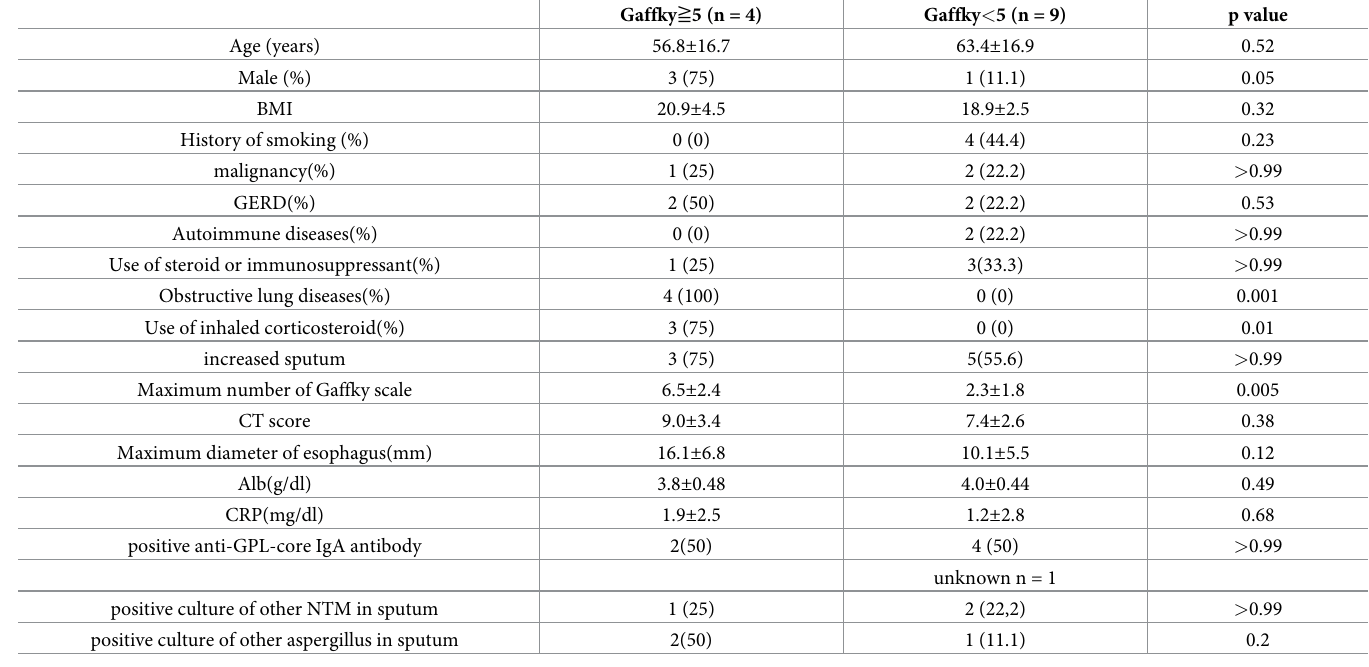
Table 4. Clinical characteristics of patients with high bacterial burden in